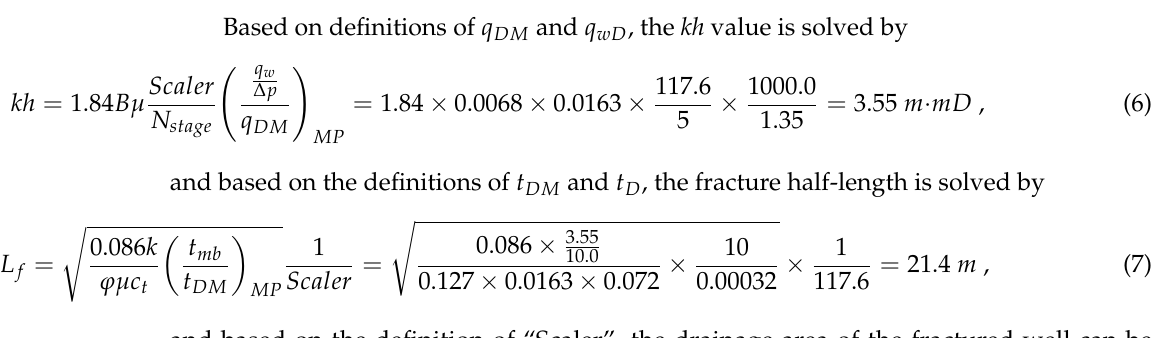
Figure 5. Type curves matching with actual data of the MHFHW